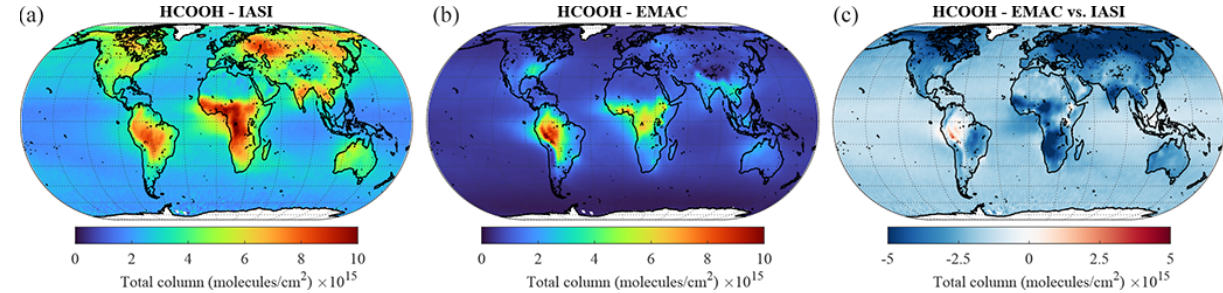
Figure 12. The same as Fig. 8 but for HCOOH.